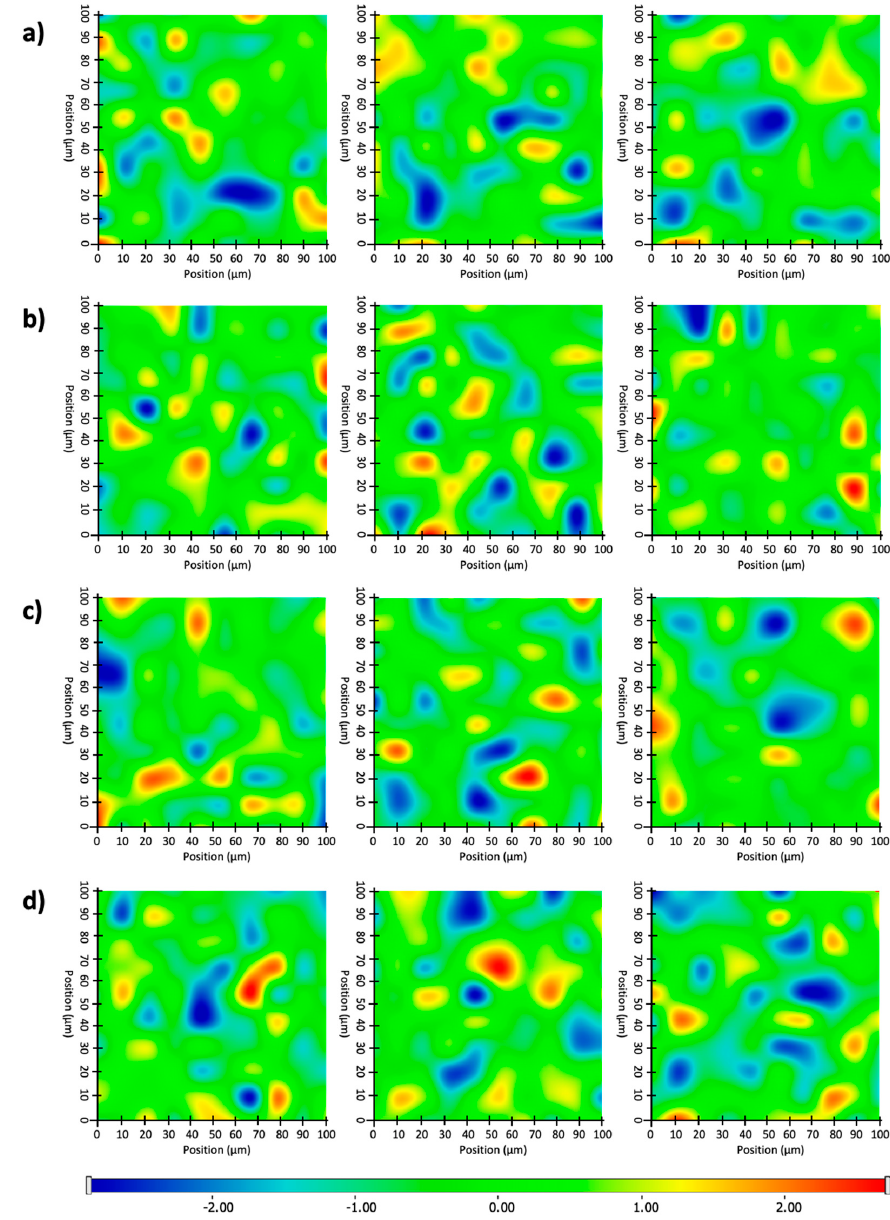
Figure 4. Raman chemical maps of randomly selected areas from three different places of various PVP- and PLA-based electrospun non-woven tissues indicating the distribution and relative occurrence of lipases and nadifloxacin entrapped within them: ( a ) RmL and CrL distribution in PVP nanofiber-based multilayered mask, ( b ) nadifloxacin distribution in PVP nanofiber-based multilayered mask, ( c ) RmL and CrL distribution in PLA nanofiber-based multilayered mask, and ( d ) nadifloxacin (NF) distribution in PLA nanofiber-based multilayered mask. The distribution of different chemical entities (belonging to lipases and nadifloxacin) was also investigated by the scanning of three different regions of the total sample. The